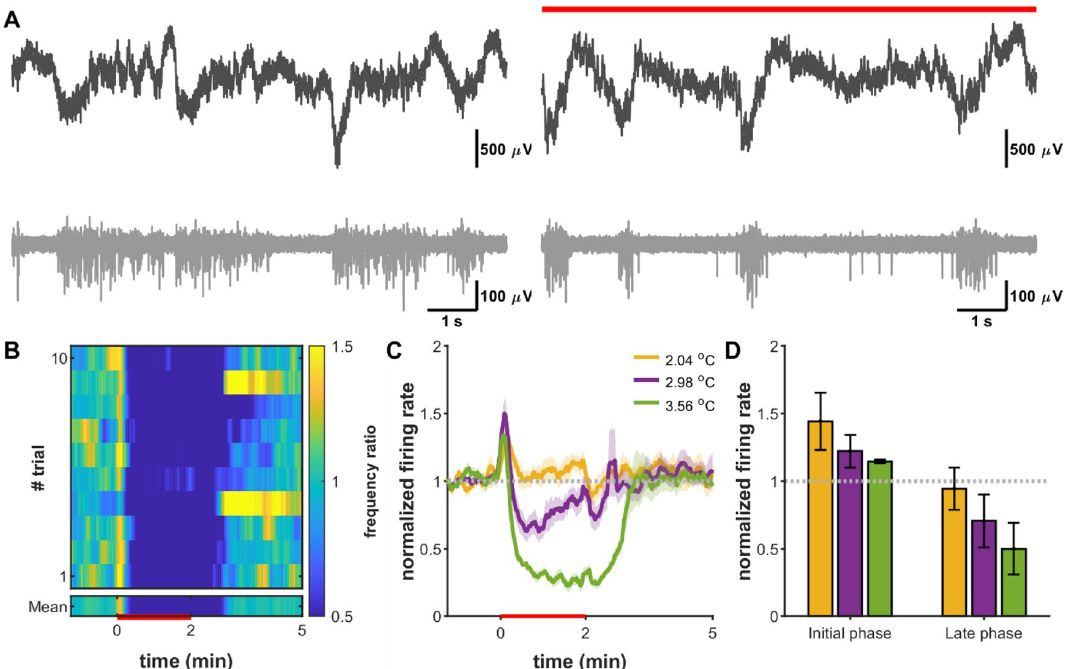
Figure 3. Infrared light induced suppression of cortical neurons. ( A ) Raw local field recording (black) and multiunit trace (gray) before (left) and during (red line) a heating session beyond the initial phase. ( B ) Average normalized spike rate across 15 trials (heat map) in case of 3.56 °C heating. ( C ) Normalized mean firing rate traces based on multiunit activity. ( D ) Cumulative normalized firing rate results from the effect of different heating protocols in the early (0–15 s) and late (48–120 s) phases of